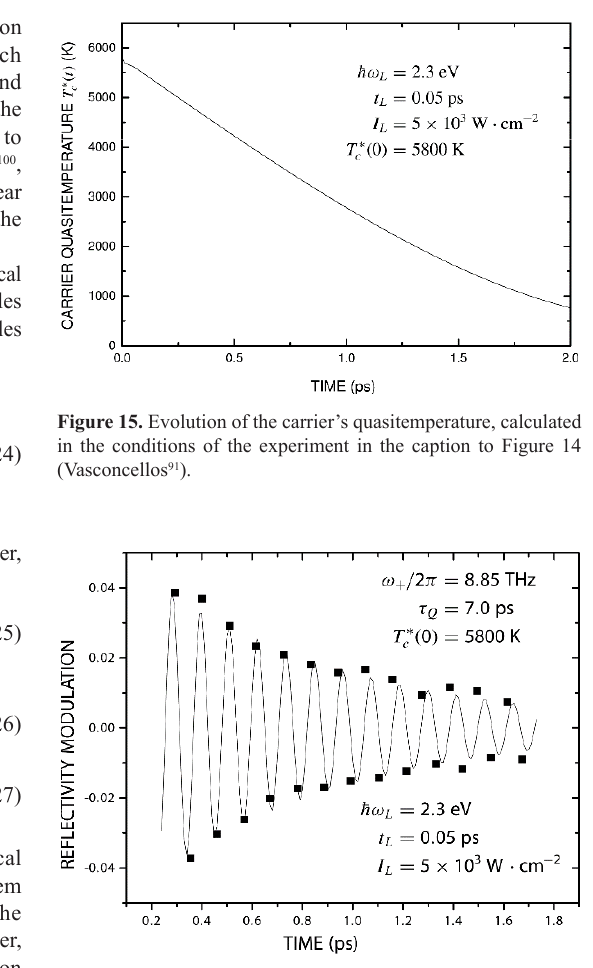
Figure 16. The theoretically evaluated modulation of the time-resolved reflectivity in the conditions of Cho et al. 85 , compared with